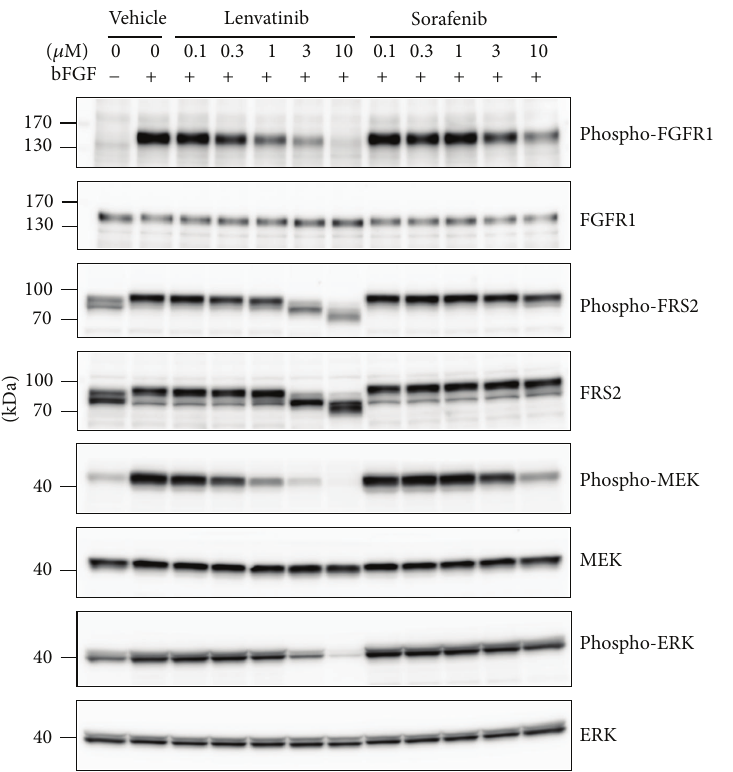
Figure 4: Effect of lenvatinib on FGFR1 signaling pathway in human DTC RO82-W-1 cells in vitro. After starvation overnight, RO82-W-1 cells were treated with vehicle (control), lenvatinib or sorafenib at the indicated concentrations for 1h and were then stimulated for 10min with bFGF (20 ng/mL) and heparin before being lysed. Western blot analyses of the phosphorylation of FGFR1 and its downstream effectors in RO82-W-1 cells were then performed and representative images were